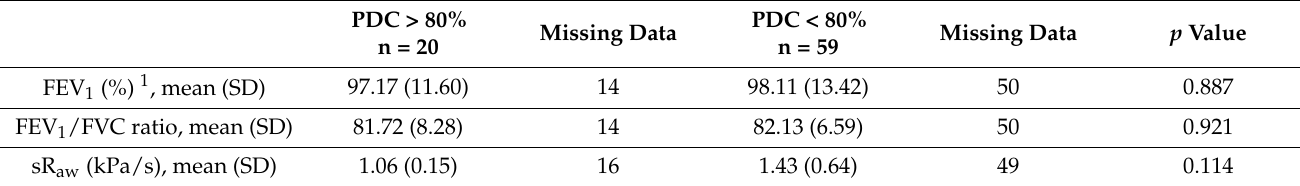
Table 5. Adherence and lung function at end